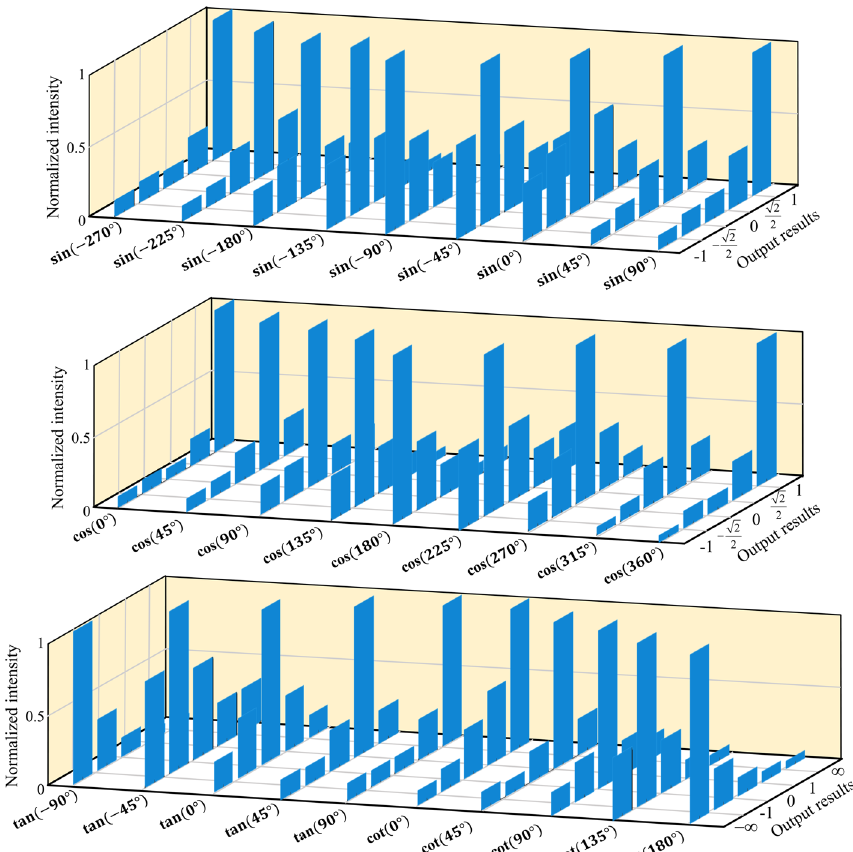
Fig. 4 The simulated output results of all the trigonometric operations, which are demonstrated in the form of